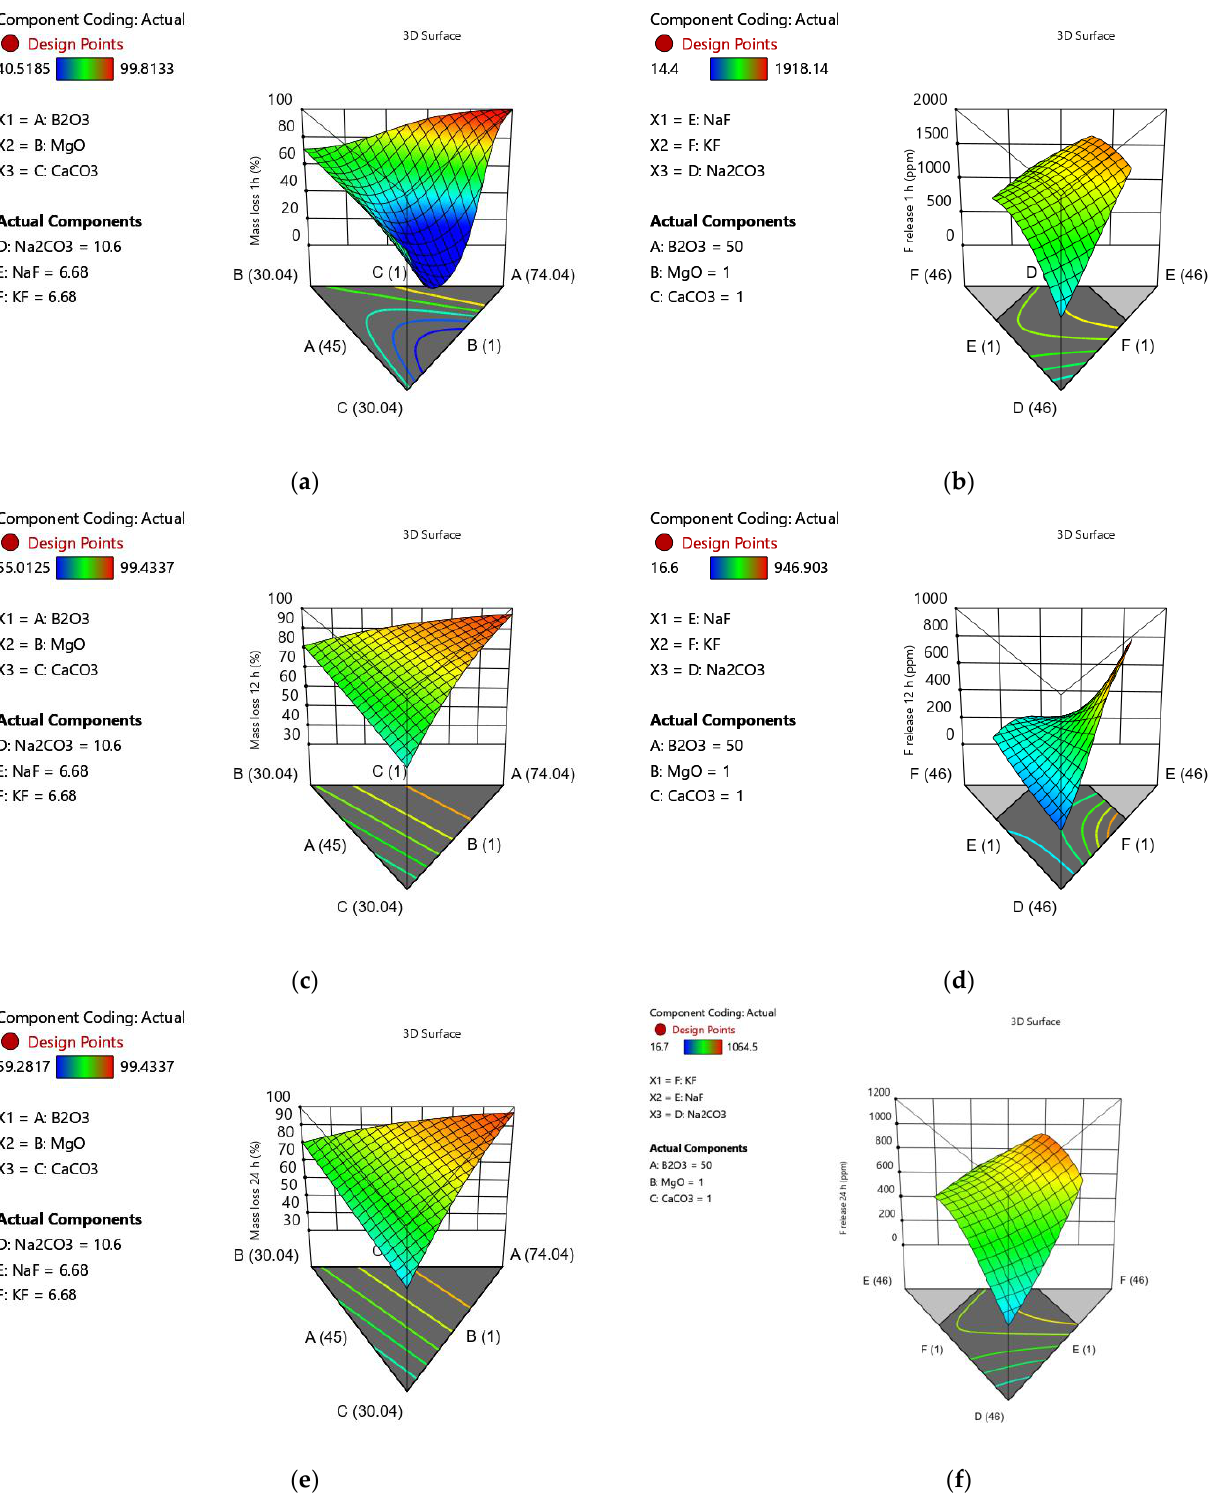
Figure 5. 3D surface plots demonstrating the nonlinear relationships between the glass composition and ( a ) 1 h mass loss, ( b ) 1 h fluoride release, ( c ) 12 h mass loss, ( d ) 12 h fluoride release, ( e ) 24 h mass loss and ( f ) 24 h fluoride release.